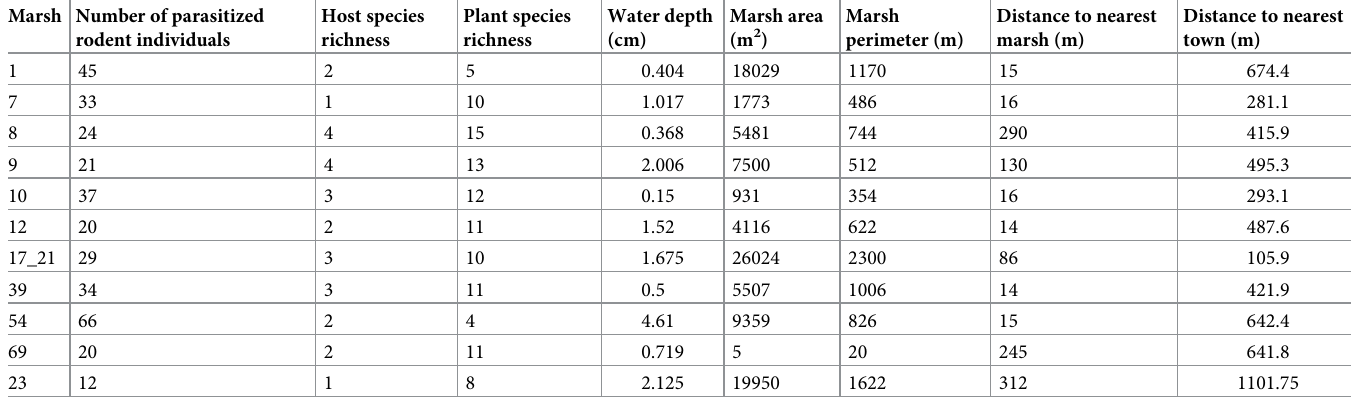
Table 2. Rodent hosts of ectoparasites and landscape characteristics of 11 marshes in Tecopa, California, US between 2011 and 2019. Marsh Number of parasitized rodent